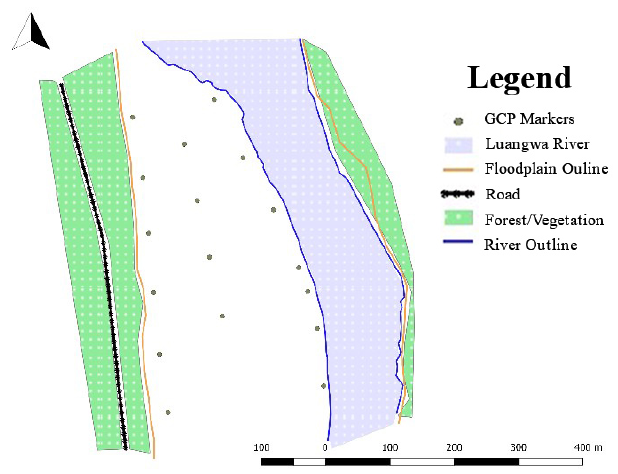
Figure 4. Spatial distribution of 17 GCPs on the